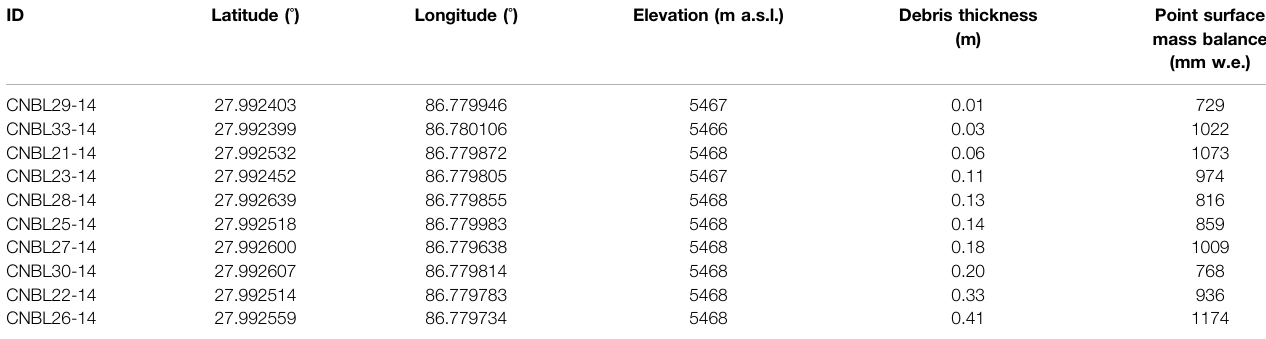
TABLE 3 | The locations of ablation stakes installed around NCN-AWS, and point surface mass balance measurements for the period 28 November 2015 to 10 November 2016. ID Latitude ( ° ) Longitude ( ° ) Elevation (m a.s.l.) Debris thickness